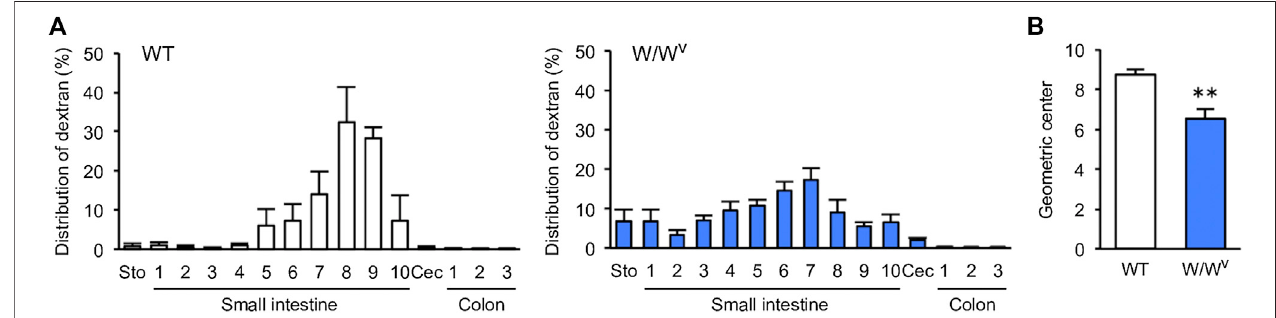
FIGURE 2 | Decrease in small intestinal transit in W / W v mice. (A) Distribution of administered FITC-dextran in WT mice and W / W v mice. The small intestine was dividedinto10equalsegments,andthecolonwasalsodividedinto3equalsegments. (B) Geometriccenter(GC)ofeachgroupcalculatedfrom (A) .Eachcolumnshows the mean ± SEM ( n (cid:2) 4 – 6). ** p < 0.01; signi fi cantly different from WT mice.